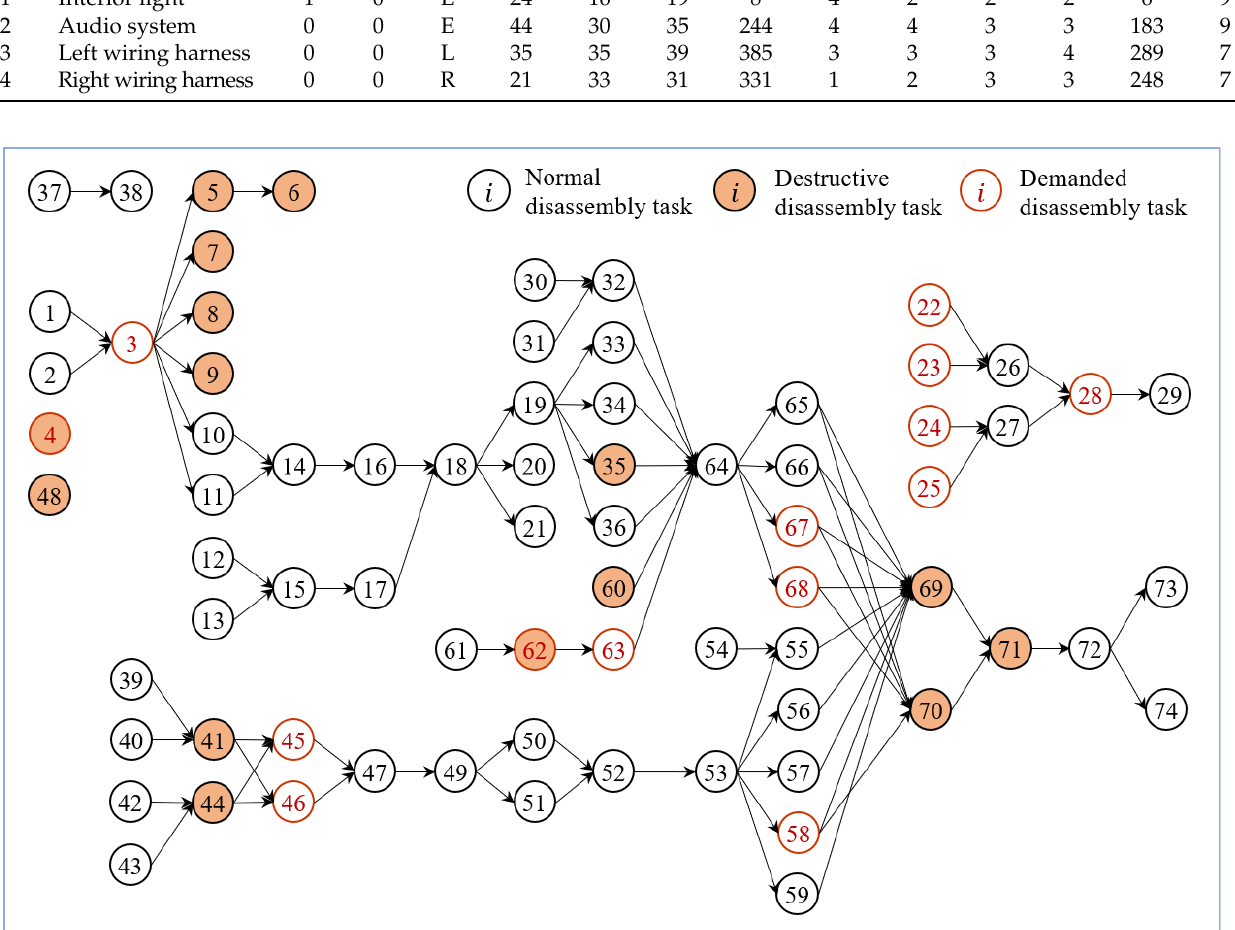
Figure 5. Precedence relationships among the parts of the waste automobile.